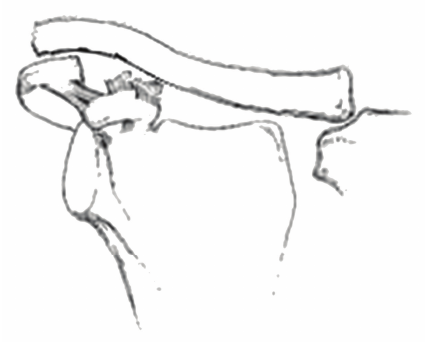
Figure 2: A schematic representation of the locked superior dislocation of the acromioclavicular joint.